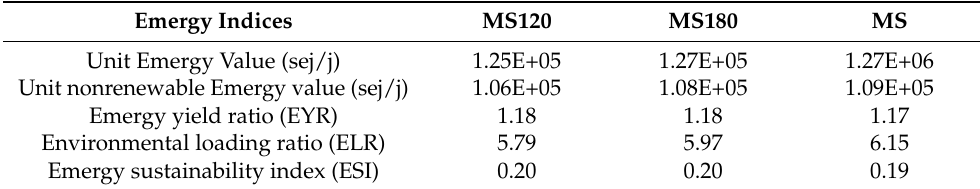
Table 6. Emergy indicators of the different N application for intercropping